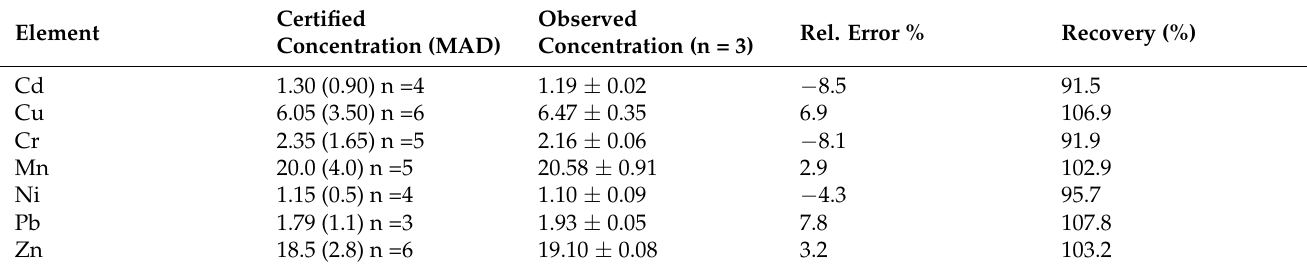
Table A1. Concentrations of Cd, Cu, Cr, Mn, Ni, Pb, and Zn (mg/kg ± S.D. in dry weight) in certified reference material (BIMEP-432) from the Wageningen Evaluating Programs for Analytical Laboratories (WEPAL). Element